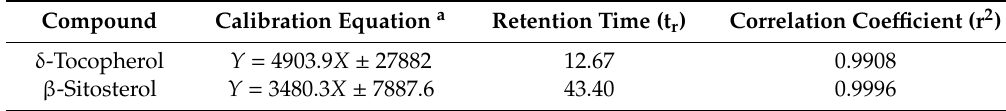
Table 2. Linearity of the standard curves of δ -tocopherol and β -sitosterol. Compound